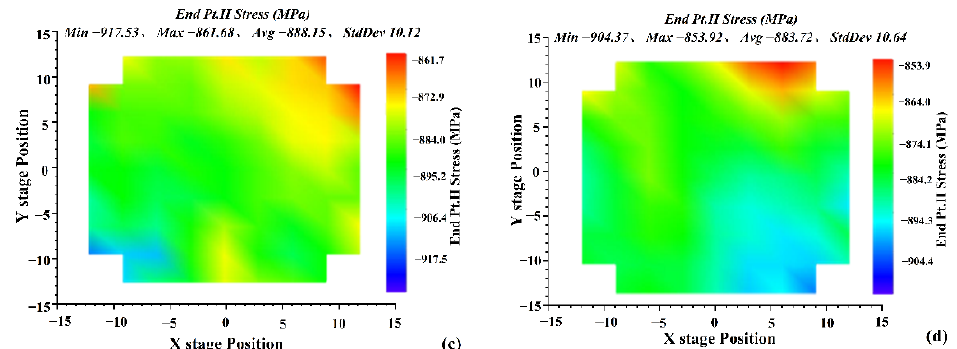
Figure 3. Stress mappings for samples deposited under various RF bias powers: ( a ) 0 W, ( b ) 20 W, ( c ) 40 W, and ( d ) 60 W.